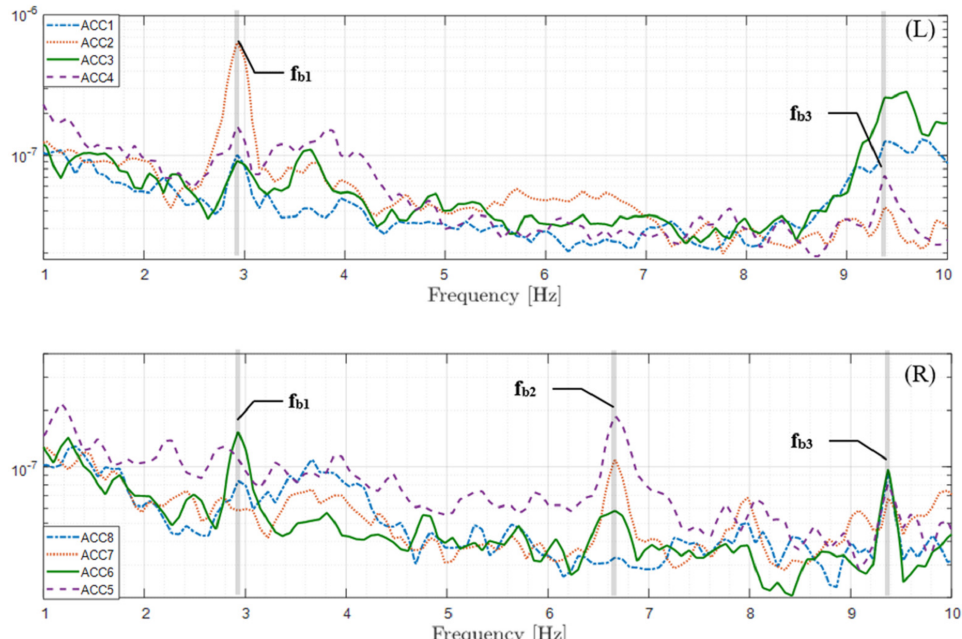
Figure 5. PSDs obtained from the acquisitions in Case 2; data from accelerometers positioned in the left sidewalk (L) and in the right sidewalk (R).